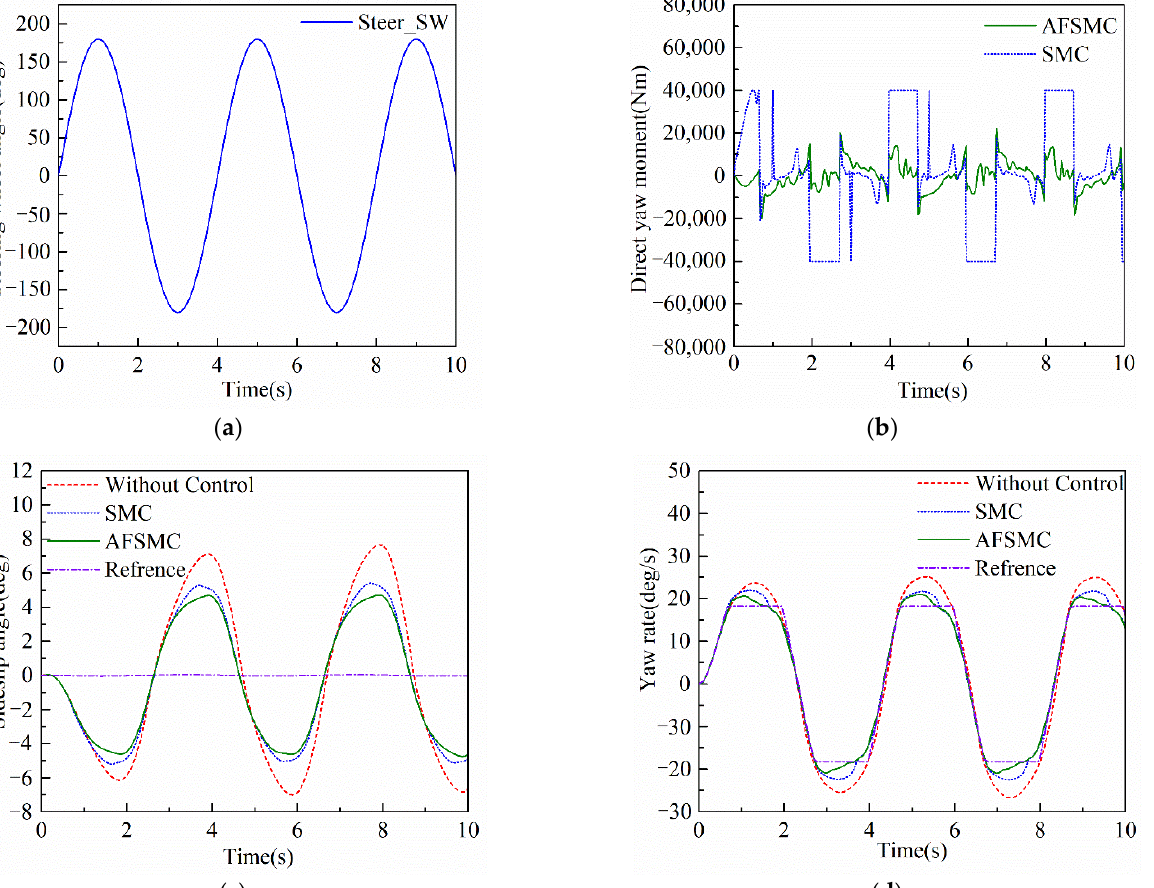
Figure 8. The simulation results of the sine wave response test. ( a ) Steering wheel angle; ( b ) direct yaw moment; ( c ) sideslip angle; ( d ) yaw rate.